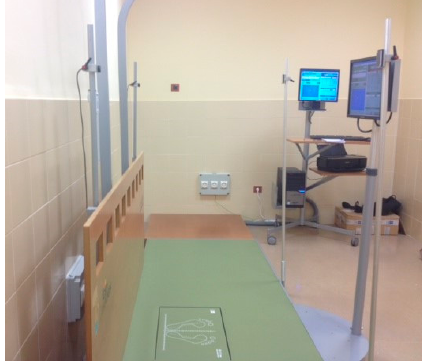
Figure 1. Dinascan/IBV force platform.